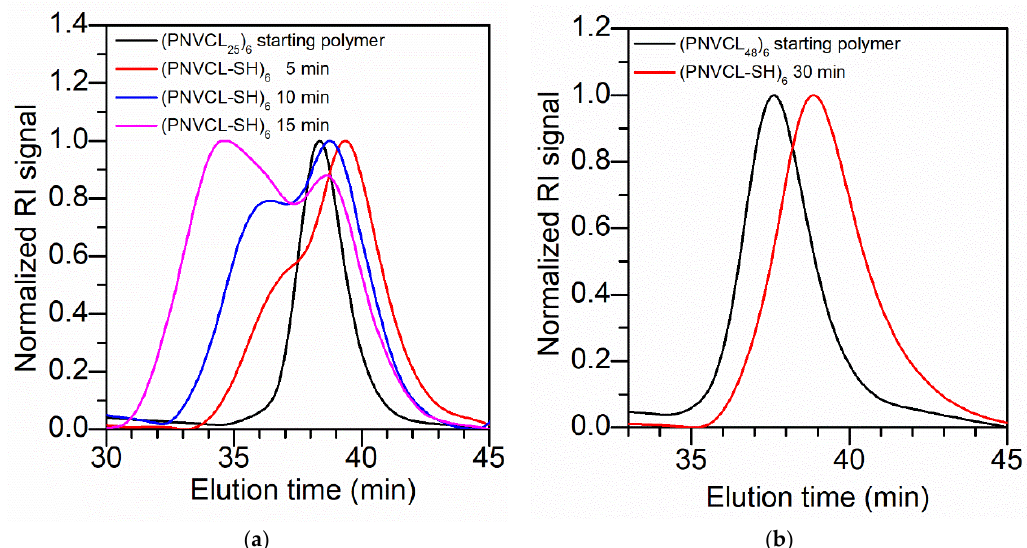
Figure 1. GPC traces in THF before and after aminolysis for (PNVCL-xanthate) 6 star polymer and (PNVCL-SH) 6 star polymer product using hexylamine (8 equiv per arm). ( a ) Reaction carried out in THF: starting polymer M n GPC = 21,100 g/mol and Ð = 1.09 (see Table S1, entry 5); 5 min M n GPC = 32,950 g/mol and Ð = 1.5; 10 min M n GPC = 42,230 g/mol and Ð = 1.54; 15 min M n GPC = 44,290 g/mol and Ð = 1.63. ( b ) Reaction in dichloromethane: starting polymer M n GPC = 39,610 g/mol and Ð = 1.15 (see Table S1, entry 1); 30 min M n GPC = 47,260 g/mol and Ð = 1.07.